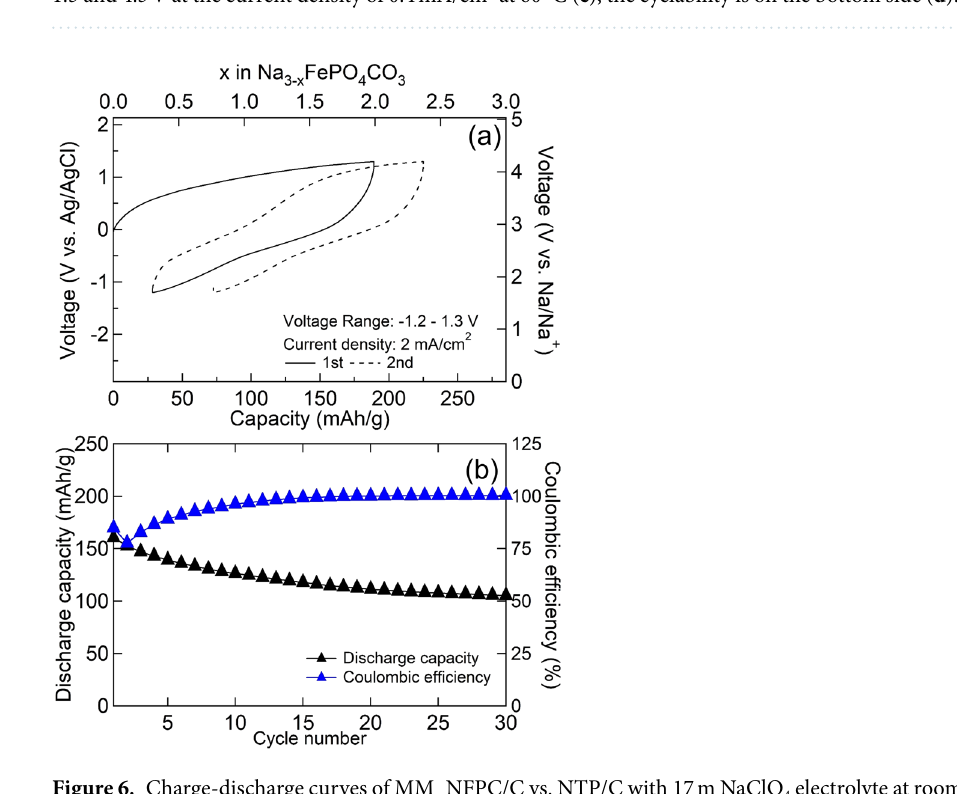
Figure 6. Charge-discharge curves of MM_NFPC/C vs. NTP/C with 17 m NaClO 4 electrolyte at room temperature ( a ); the cyclability is on the bottom side ( b